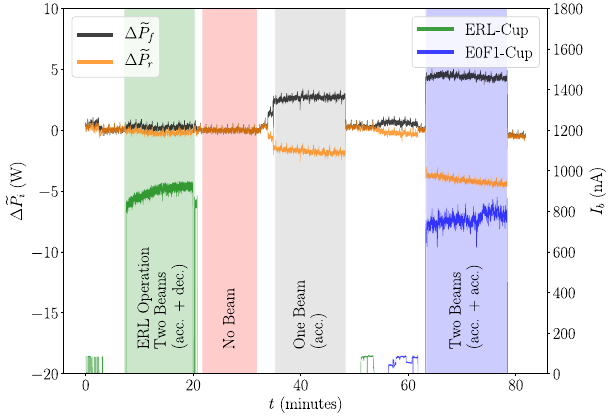
FIG. 8. During four different settings (ERL: green, no beam: red, single pass: grey, twice accelerating: blue) the changes in forward (black curve) and reverse (orange curve) rf power of the first main accelerating cavity (A1SC01, see Fig. 2) have been monitored. The beam current on the corresponding Faraday cups (ERL-Cup: green, E0F1-Cup: blue, see Fig. 2) was